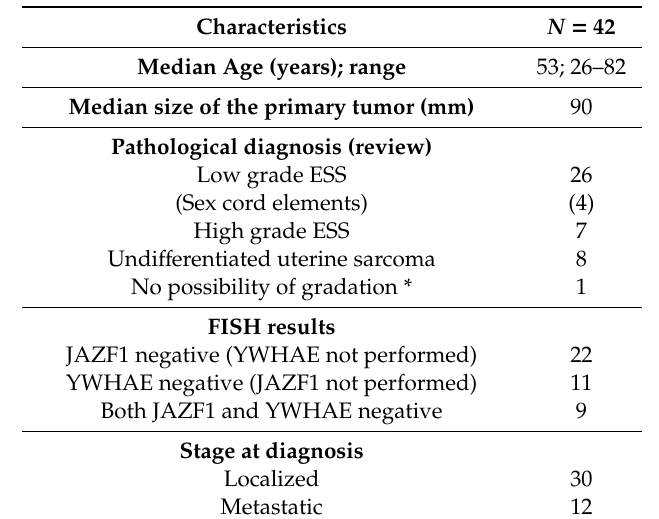
Table 1. Clinical and pathological characteristics of the investigational series of endometrial stromal sarcoma